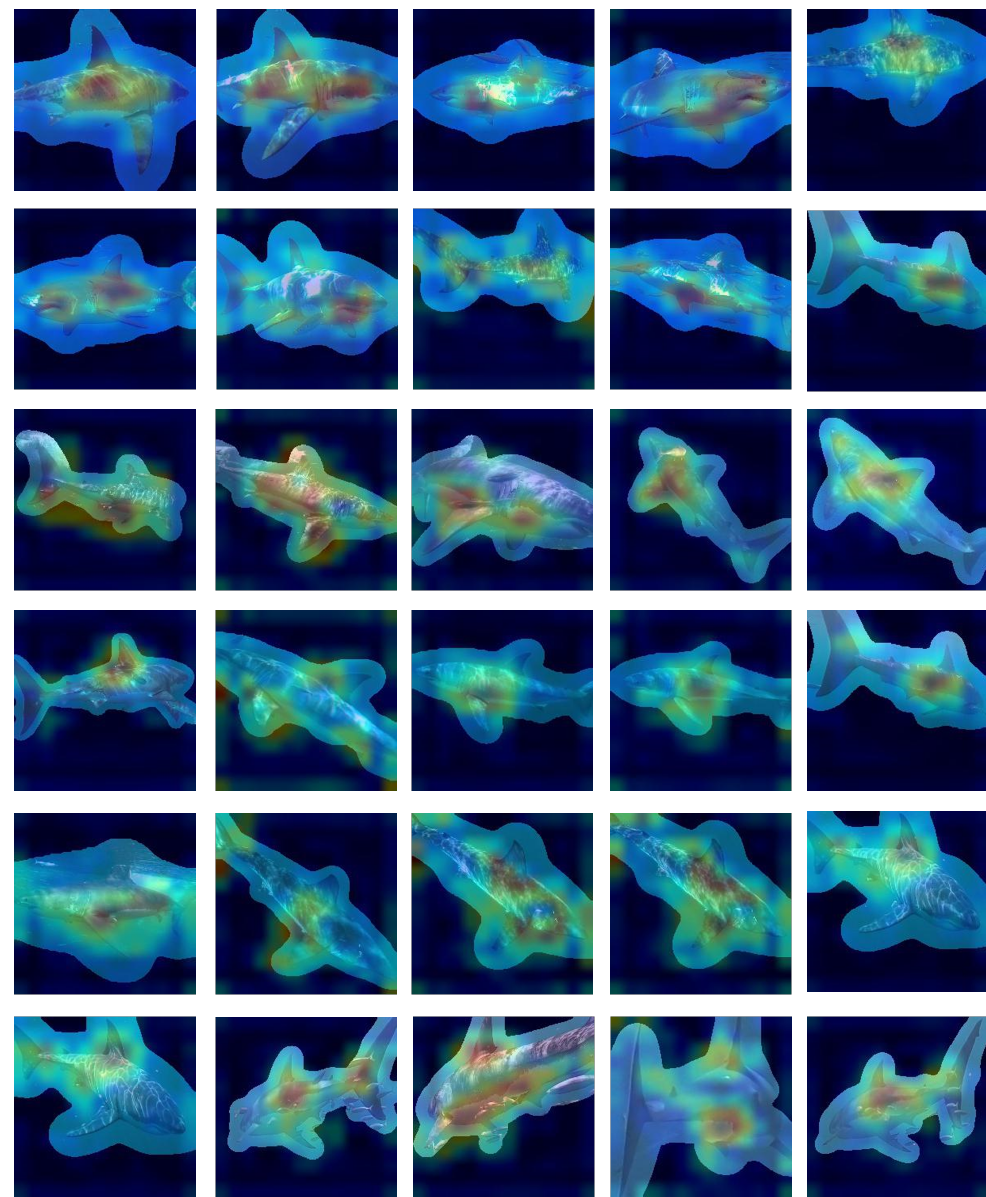
Figure 10. Visualization of activated regions using the Grad-CAM